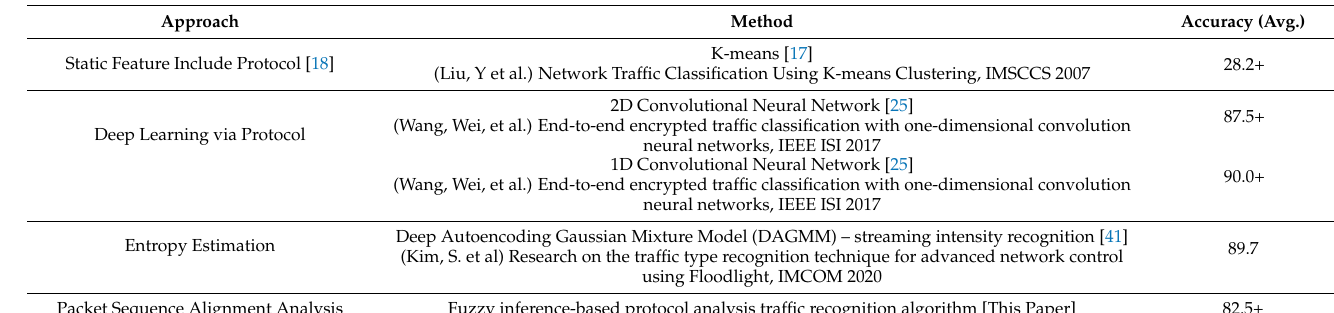
Table 5. Benchmark with state-of-the-art